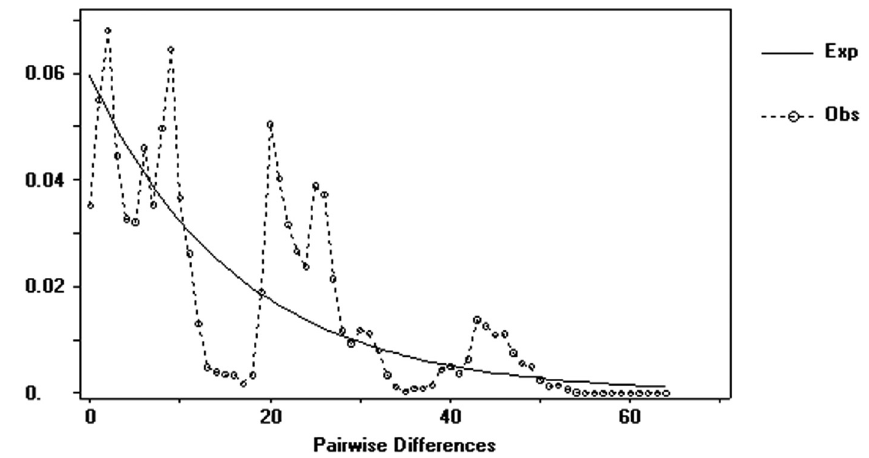
Fig. 3. Mismatch distribution for the 11 inferred populations of M.